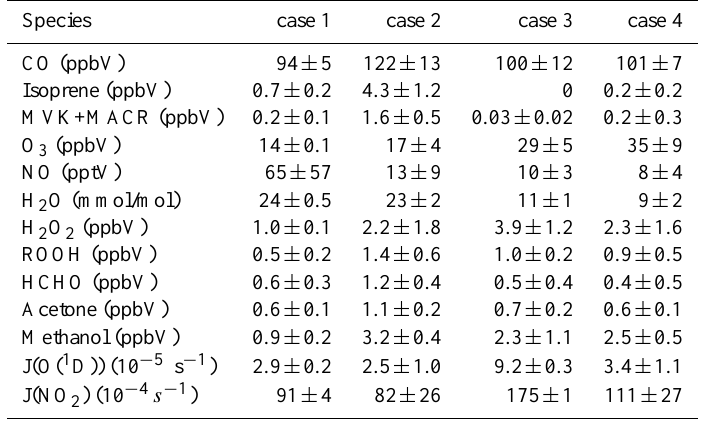
Table 9. Averaged mixing ratios for the parameters which constrain the box model simulations. The values are given for the four cases in Table 7 and 8 with their 1 σ